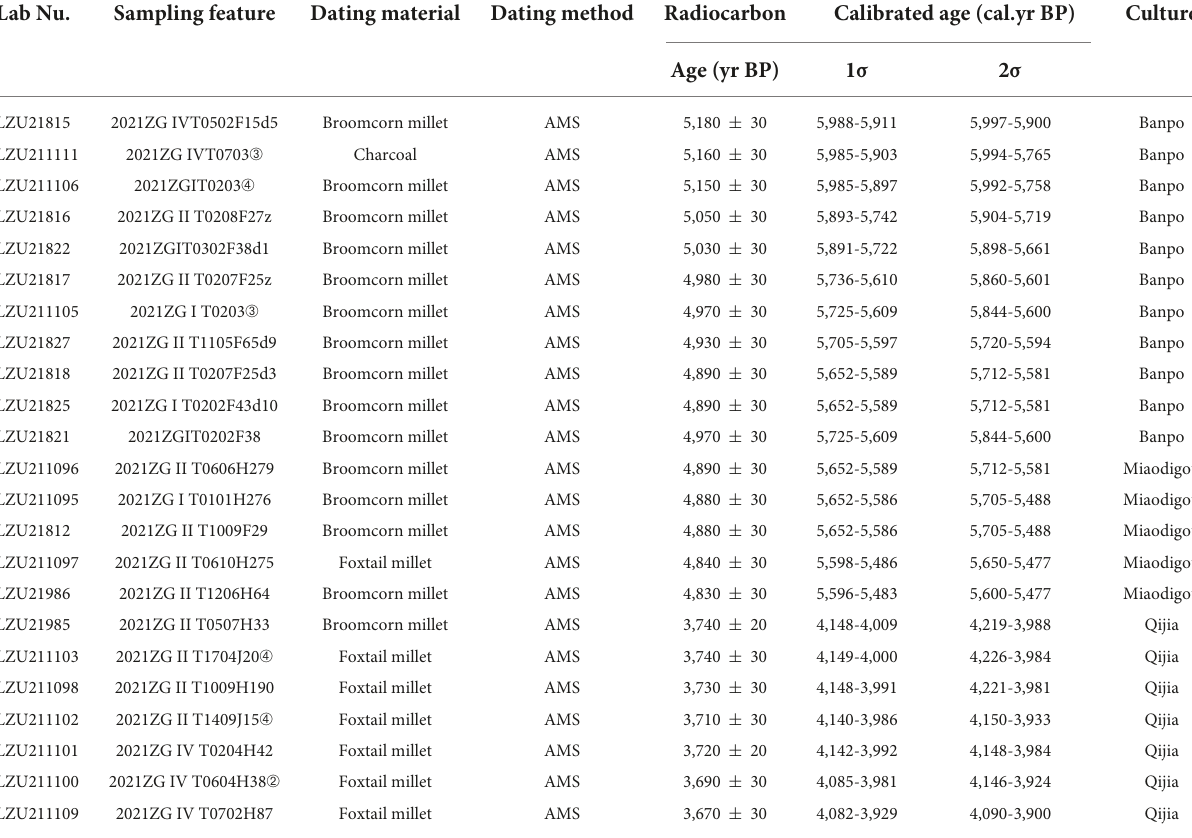
TABLE 1 Calibrated radiocarbon dates of charred crop grains from the excavation of the Gedachuan site. Lab